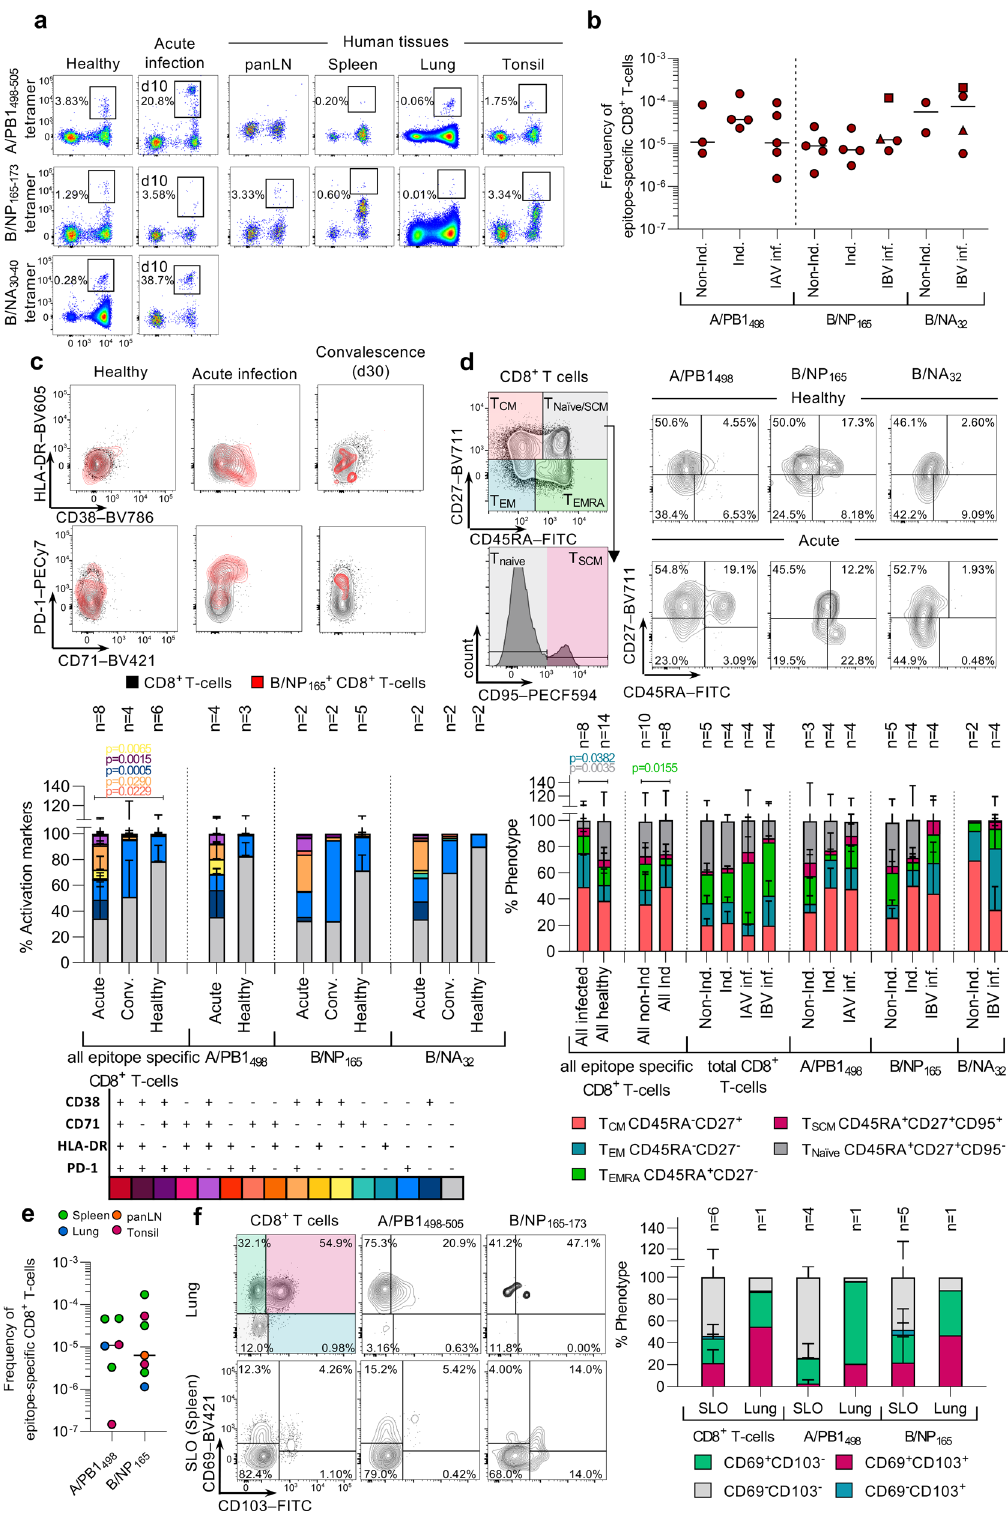
Interestingly, as per our analysis in HLA-A * 02:01-positive in fl uenza patients 24 , the frequencies of A/PB1 498 + , B/NP 165 + and B/NA 32 + CD8 + T-cells in blood of IAV- and IBV-infected patients during infection were comparable to that of memory CD8 + T-cell frequencies (Fig. 6b) This, most likely re fl ects the accumulation of in fl uenza-speci fi c CD8 + T-cells at the site of infection rather than in the peripheral blood. However,